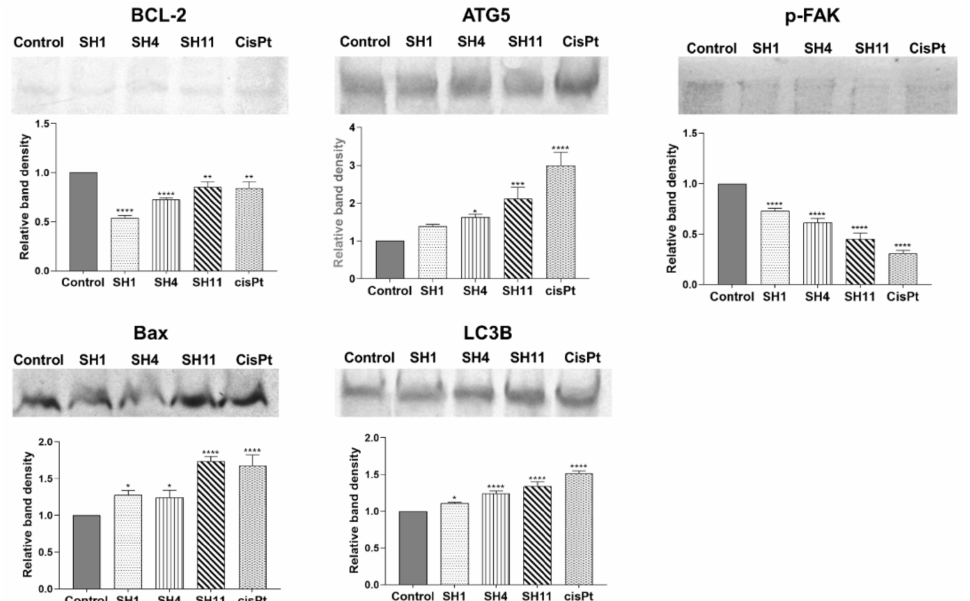
Figure 5. Western blot analyses of BCL-2, Bax, ATG5, LC3B, and p-FAK expression in MCF-7 cells after 24-h incubation with SH1 , SH4 , SH11 , and cisPt. The tested concentrations were 800 µ g/mL for SH1 and SH4 , 400 µ g/mL for SH11 , and 100 µ M for cisPt. Results are presented as mean optical density ± SD from three measurements. Statistical significance was calculated using one-way ANOVA with Bonferroni multiple comparison test. Differences were considered statistically significant at * ( p ≤ 0.05), ** ( p ≤ 0.005),*** ( p ≤ 0.0005), and **** ( p ≤